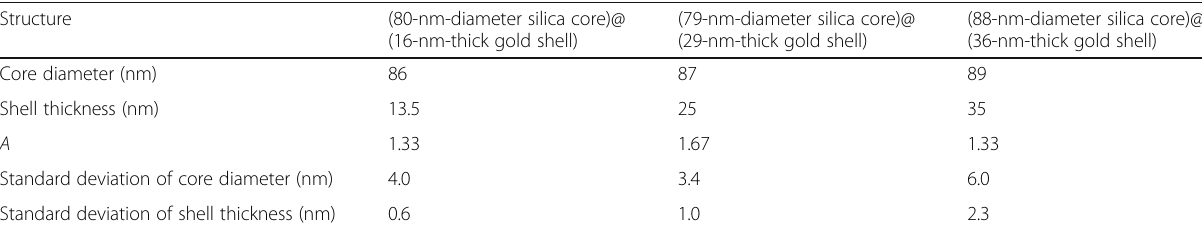
Table 2 Values of the fitting parameters for the calculated spectrums shown in Fig. 4